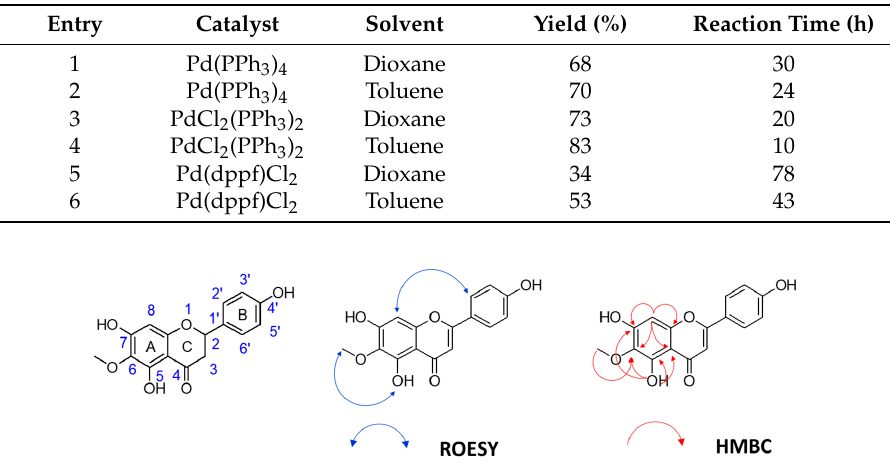
Figure 4. Key ROESY and HMBC correlations of hispidulin.